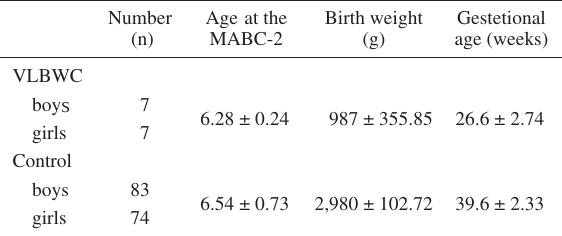
Table 1. Clinical characteristics of the 6-year-old very low birth weight children (VLBWC) group and the control